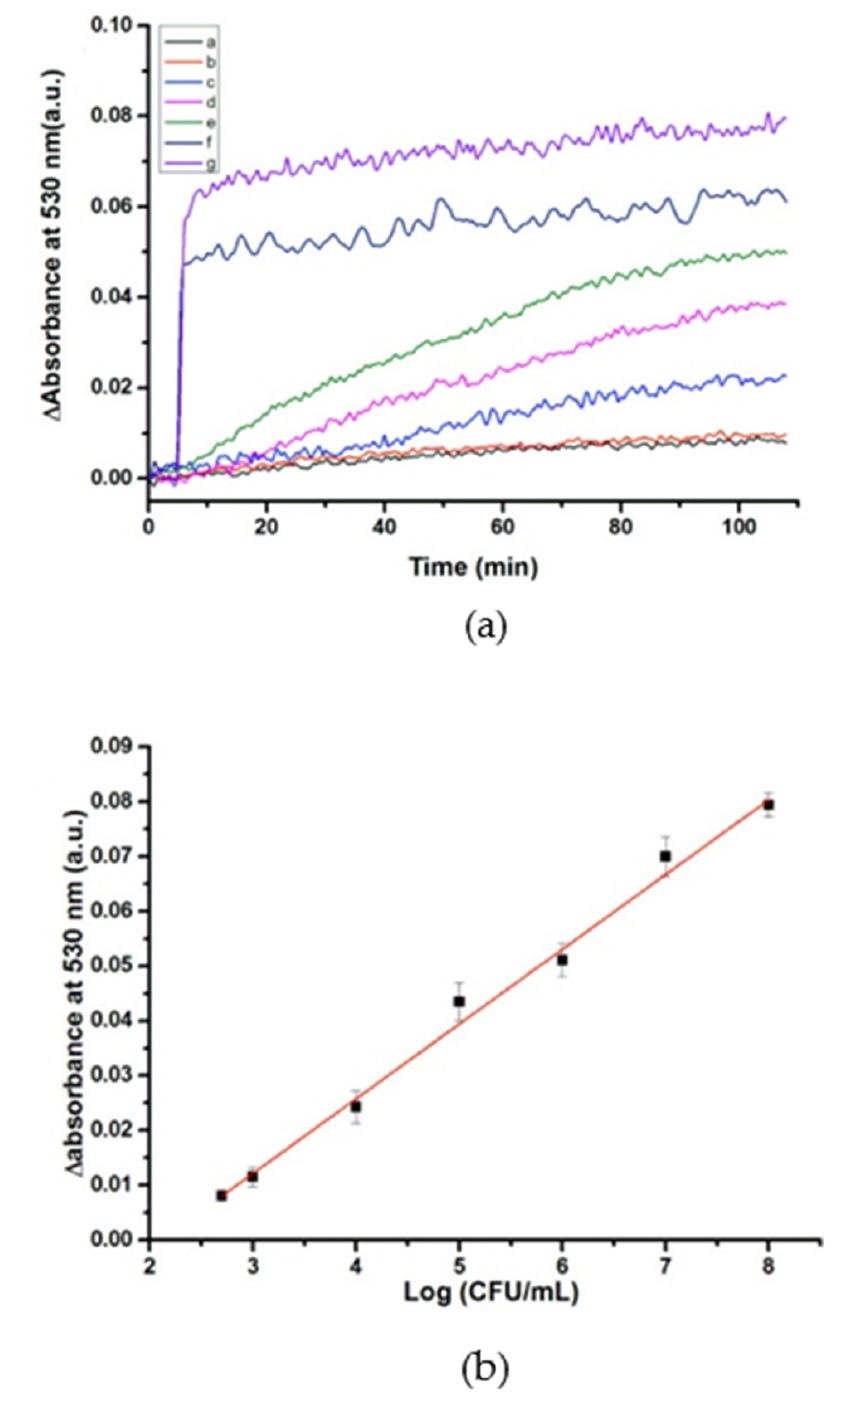
Figure 12. ( a ) Absorbance variations at 530 nm for (a) 5 × 10 2 CFU/mL, (b) 1 × 10 3 CFU/mL, (c) 1 × 10 4 CFU/mL, (d) 1 × 10 5 CFU/mL, (e) 1 × 10 6 CFU/mL (f) 1 × 10 7 CFU/mL, and (g) 1 × 10 8 CFU/mL concentrations of S. typhimurium . ( b ) Linear relationship between the variation of the absorbance at 530 nm and the concentration of S. typhimurium (logarithmic scale). Reprinted with permission from [102].